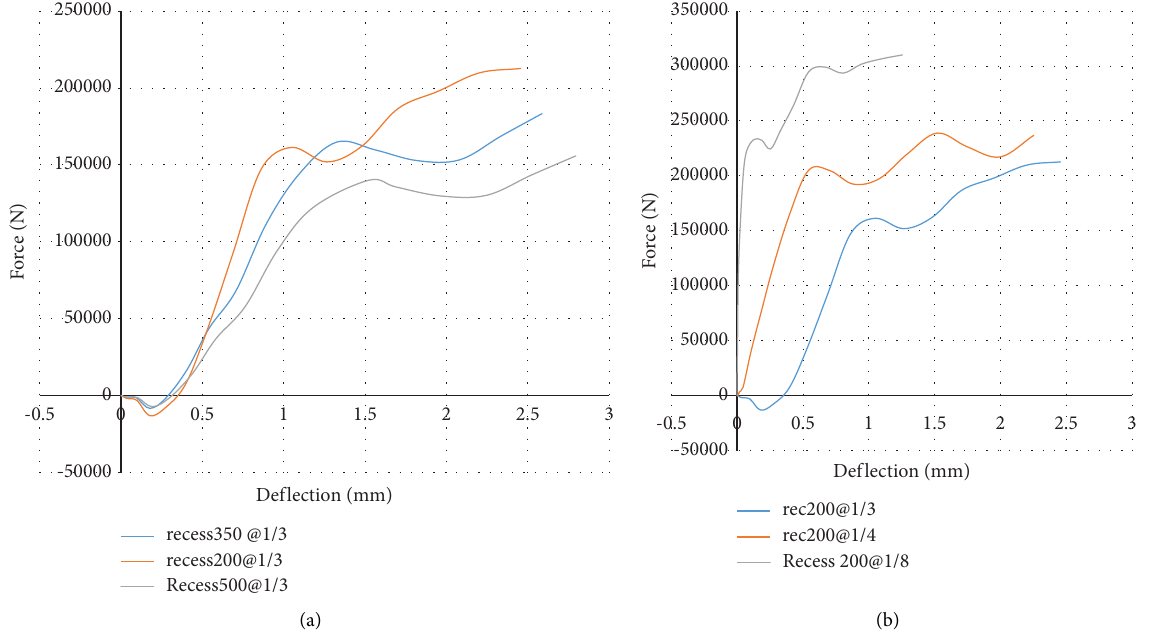
Figure 9: (a): Force vs defection curve for recess length 200, 350, and 500. (b): Force vs defection curve for recess length 200 at diferent impact